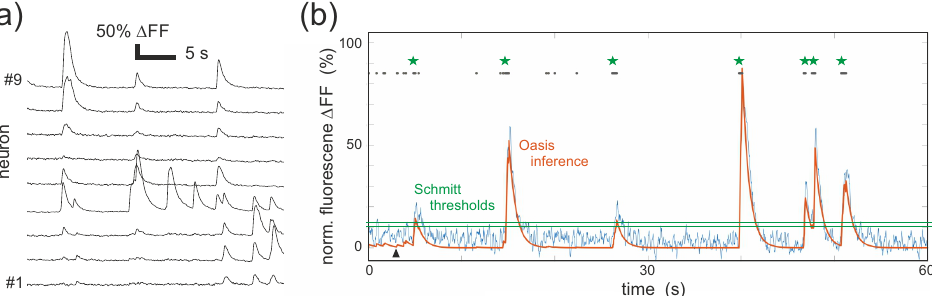
Figure 3. Fluorescence calcium imaging and spikes inference. ( a ) example of normalized fluorescence traces for nine neurons in a typical experiment with primary cultures. Data were acquired with the genetically encoded calcium indicator GCaMP6s. Sharp increases in the signal reveal the emission of action potentials; ( b ) neuronal spikes inference, in which the original fluorescence trace (blue signal) is analyzed to obtain the spikes via the Schmitt trigger method (green lines and stars) or the Oasis method (red curve and black dots). The latter uses biophysical information to predict the fluorescence signal and its containing spikes, but errors occur (black arrowhead towards the beginning of the recording), with noisy fluctuations in the signal being ascribed as